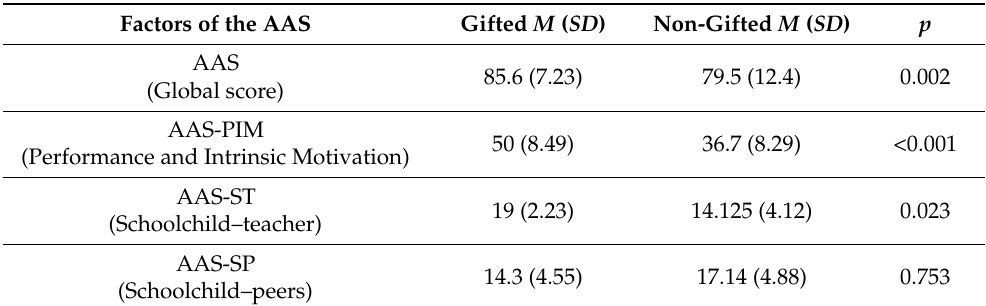
Table 4. Comparison of the scores of gifted and non-gifted on the AAS, with means (M), standard deviations (SD), and p